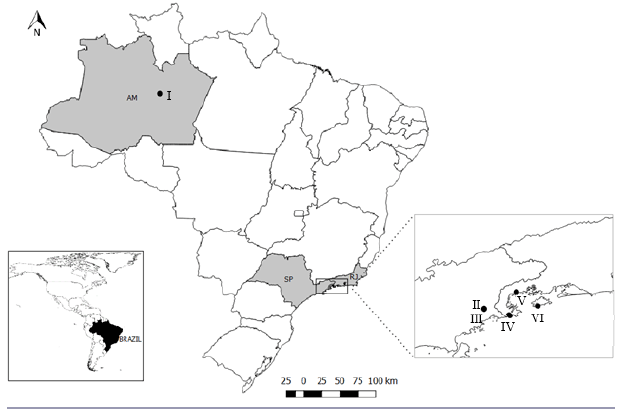
Fig. 1. Communities with successful self-organization to solve specific socio-environmental issues and their location in Brazil: I - Capivara Sector, Middle Solimões River, Amazonas; II - São Luiz do Paraitinga, São Paulo; III - REDESUAPA, Upper Paraíba do Sul River, São Paulo; IV - Trindade, Paraty, Rio de Janeiro; V - Tarituba, Paraty, Rio de Janeiro; VI - Aventureiro, Ilha Grande, Rio de